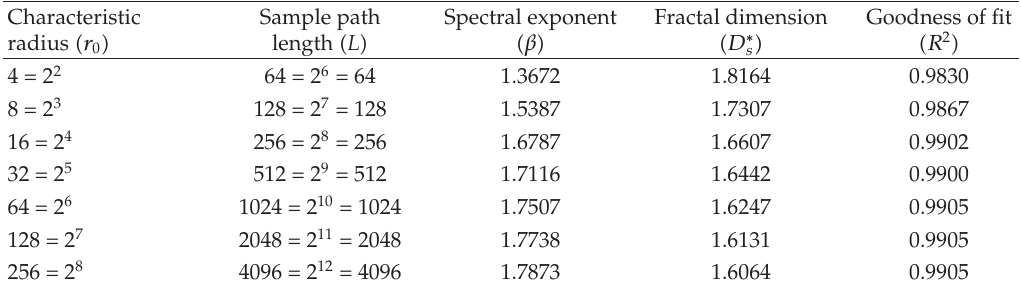
Table 3: Spectral exponent, fractal dimension, and related parameter values based on the standard exponential distributions (cid:3) partial results (cid:4)